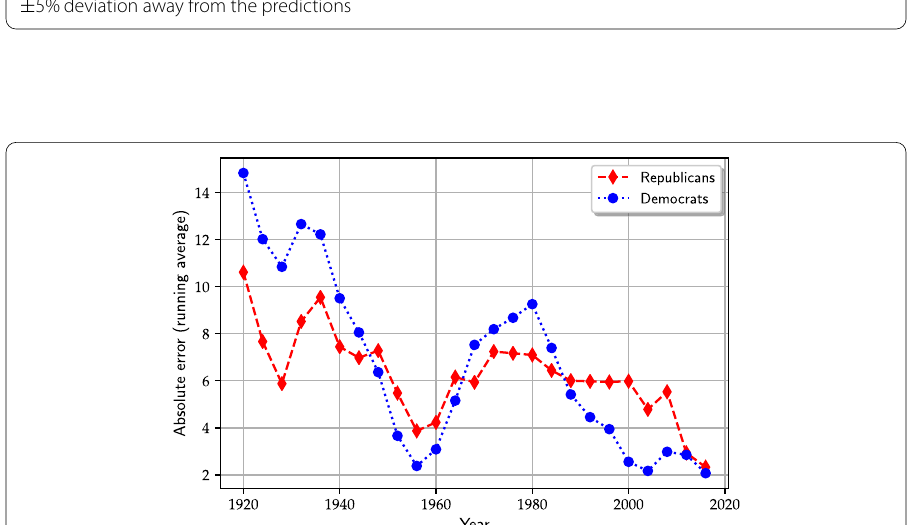
Fig. 6 Absolute error between prediction and reality for the US elections, running average over the last 5